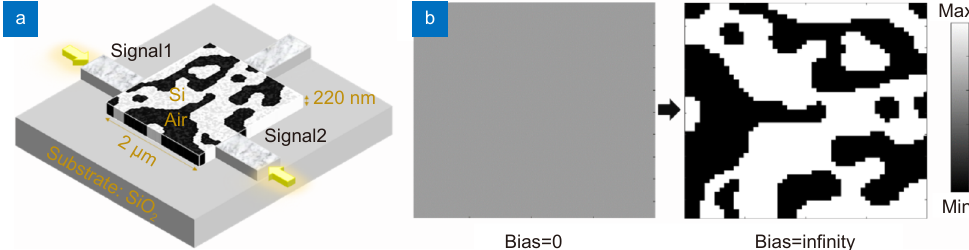
Fig. 4 | Design optimization process of all-optical XOR logic gate. ( a ) General configuration of the all-optical XOR logic gate. ( b ) The initializ- ation and discrete optimization permittivity distribution in the x - y two-dimensional cross-section, where bias=0 and bias=infinity.